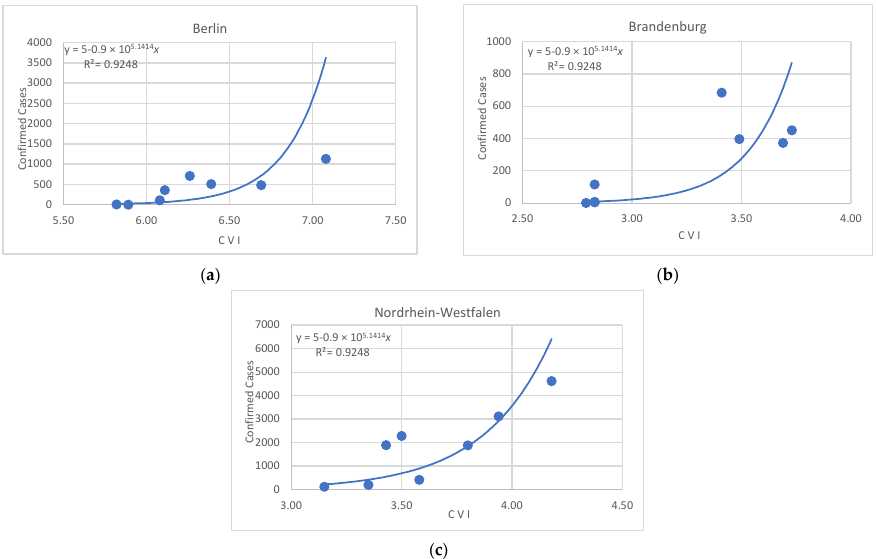
Figure 16. The CVI and new cases relation in the ( a ) Berlin, ( b ) Brandenburg and ( c ) Nordrhein- Westfalen.